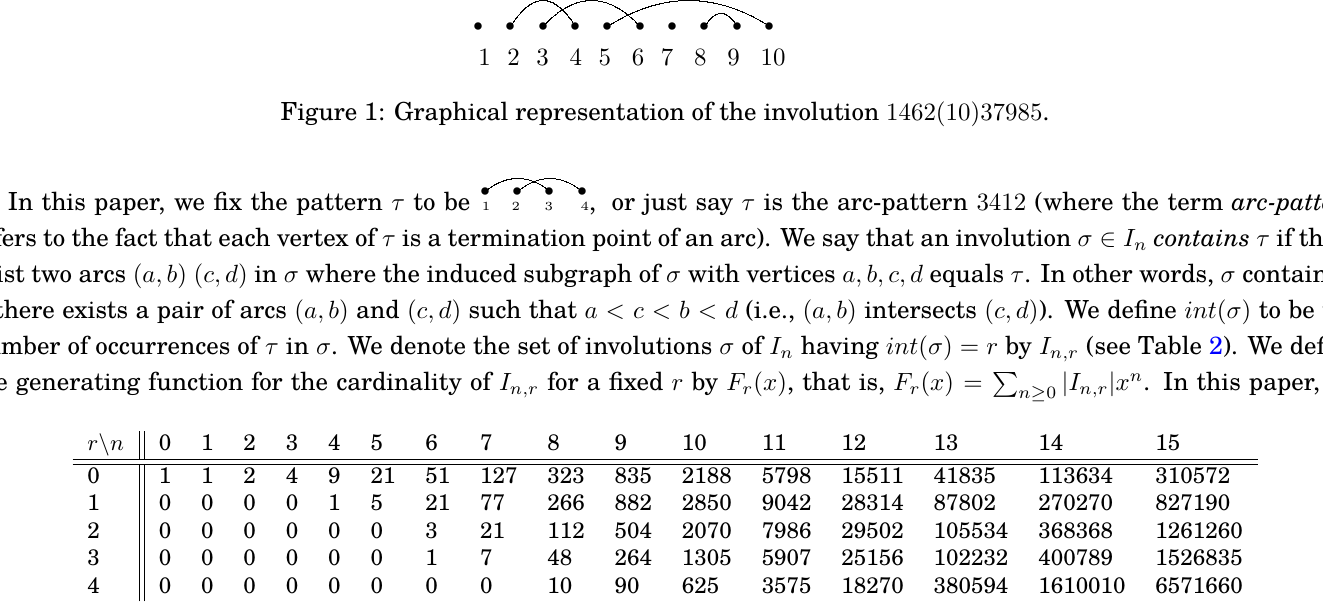
Figure 1: Graphical representation of the involution 1462(10)37985 .